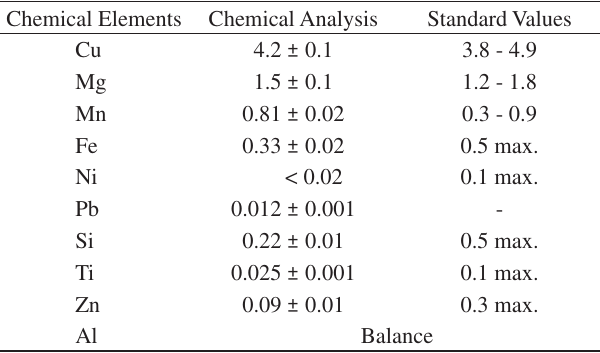
Table 1. D16T alloy chemical composition in weight percent.